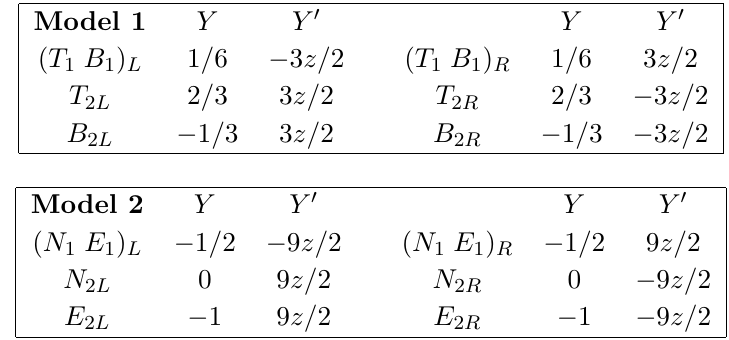
Table 1 . Hypercharge assignments for the SM fermions, with z a free parameter. The columns labelled with Y collect the standard hypercharges with the normalisation Q = T 3 + Y .